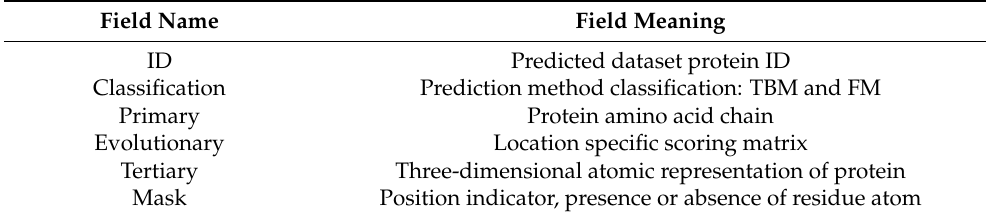
Table 1. Main fields of RGN input